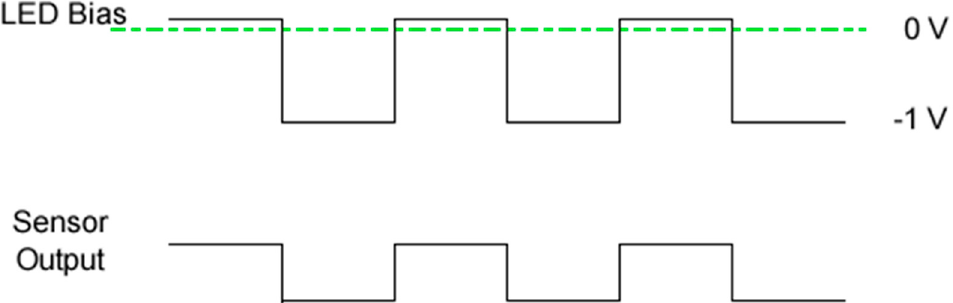
Figure 1. LED bias voltage and sensor response, showing the modulated voltage signal method